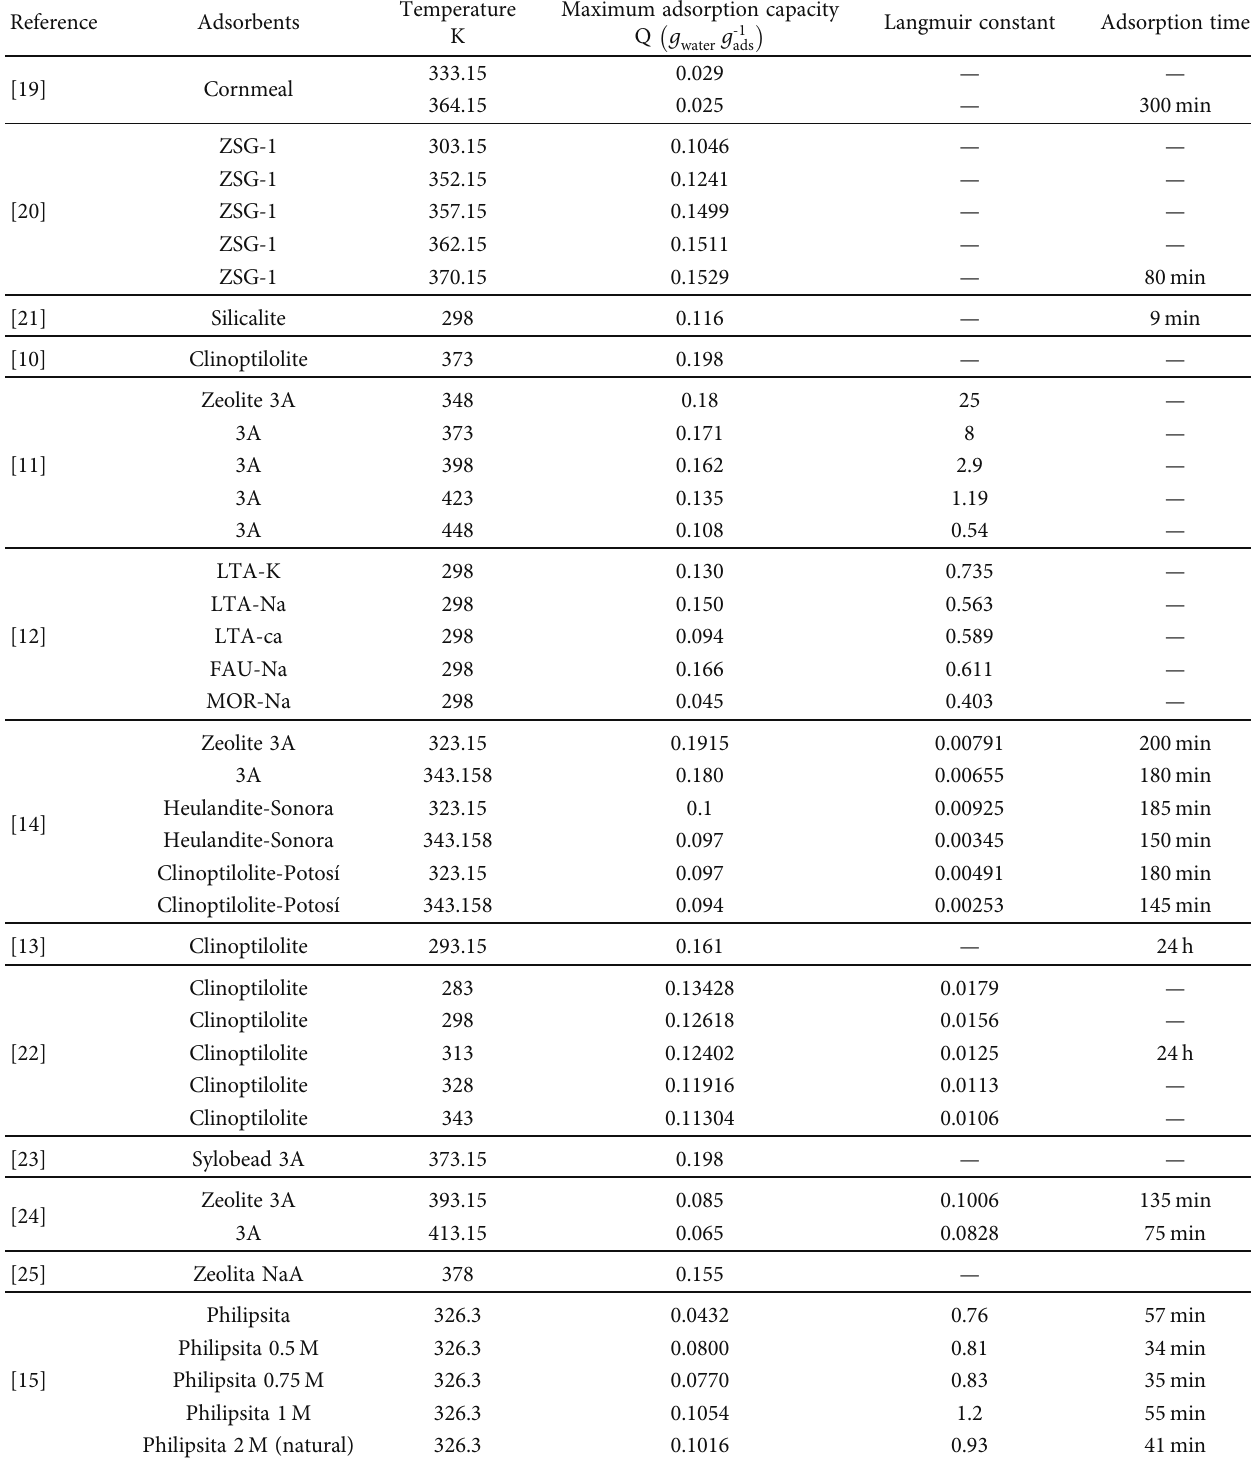
Table 2: Comparison of the thermodynamic values of various adsorbents as a function of